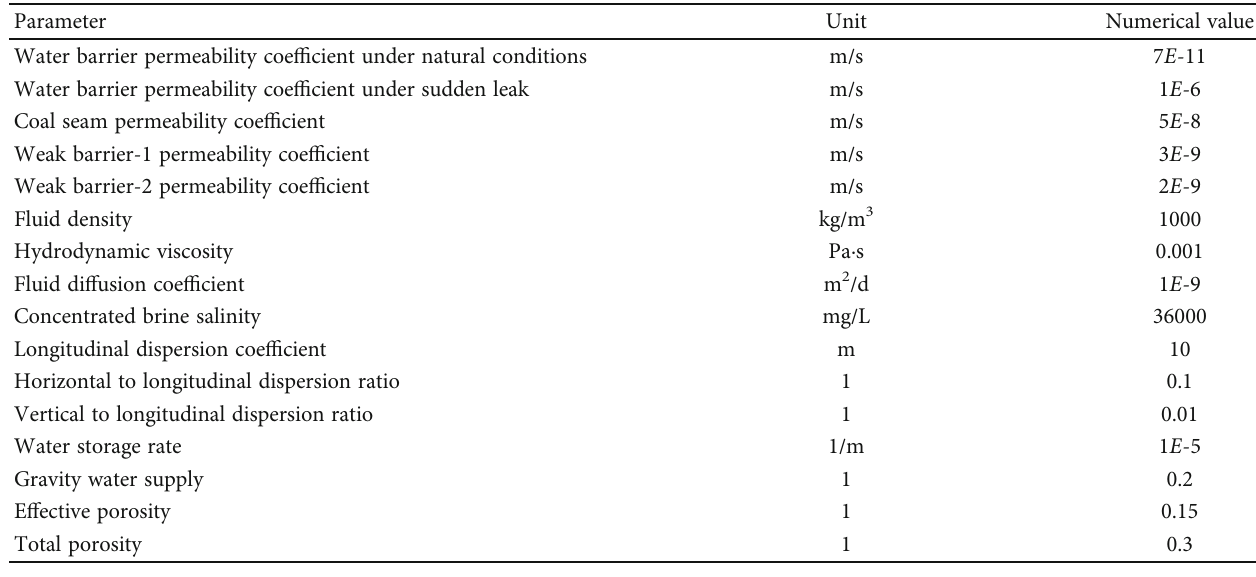
Table 2: Selection of calculation parameters.